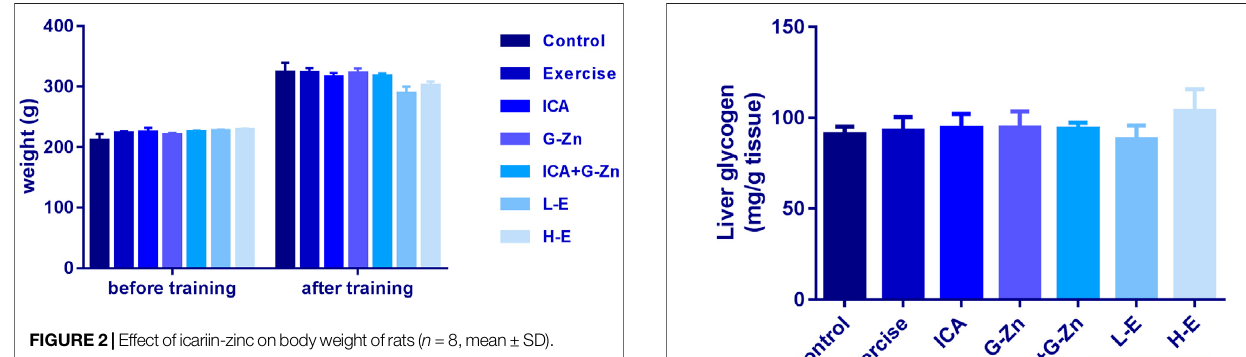
FIGURE2| Effectoficariin-zinconbodyweightofrats( n (cid:2) 8,mean ± SD).